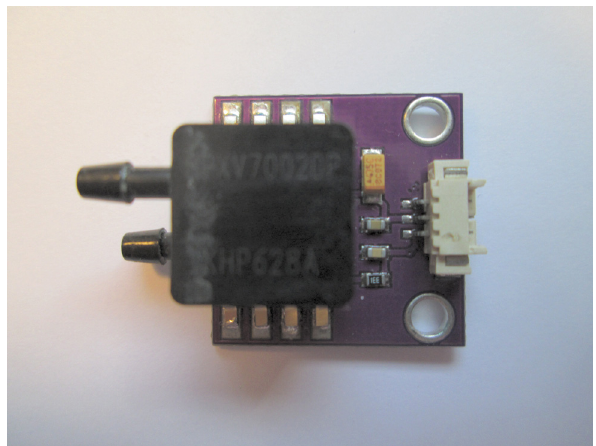
Figure 15: Di ff erential pressure sensor MPXV7002DP on a breakout board.